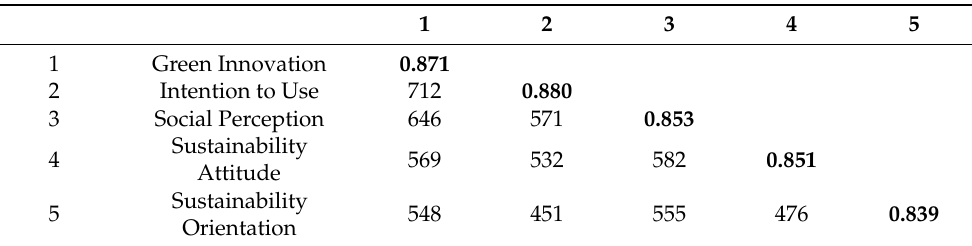
Table 4. The Fornell–Larcker criterion analysis for discriminant validity.